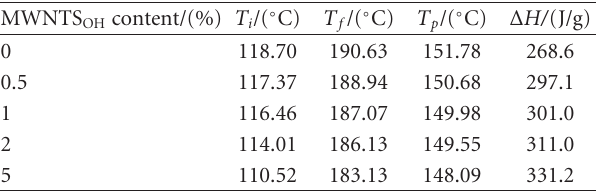
Figure 1: Gel time of MWNTS OH /epoxy resin nanocomposites versus temperature. Table 1: The influence of MWNTS OH on the thermal properties of